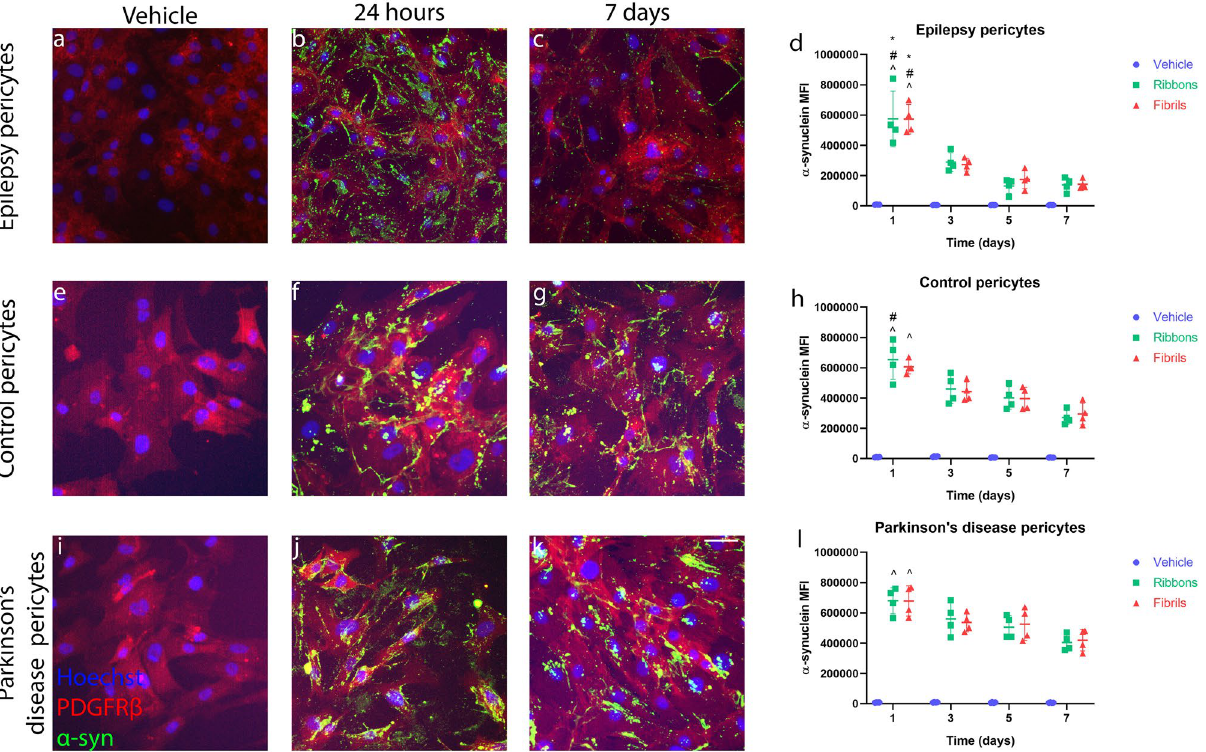
Figure 5. Degradation of α-syn in primary human brain pericytes. Immunocytochemistry images of pericytes incubated with α-syn fibrils (50 nM) for ( a ) vehicle, ( b ) 24 h, ( c ) 7 days in epilepsy pericytes. ( d ) α-syn MFI was measured using fixed flow cytometry with ribbons (50 nM) or fibrils (50 nM) over 7 days in epilepsy pericytes. Post-mortem control pericytes were exposed to α-syn fibrils (50 nM) for ( e ) vehicle, ( f ) 24 h, ( g ) 7 days in epilepsy pericytes. ( h ) α-syn MFI was measured using fixed flow cytometry with ribbons (50 nM) or fibrils (50 nM) over 7 days in control pericytes. Post-mortem PD pericytes were exposed to α-syn fibrils (50 nM) for ( i ) vehicle, ( j ) 24 h, ( k ) 7 days Scale bar = 10 µm. ( l ) α-syn MFI was measured using fixed flow cytometry with ribbons (50 nM) or fibrils (50 nM) over 7 days in control pericytes. Scale bar = 10 µm. ( n = 4 in each group, mean ± SD). * p < 0.05 compared to 3 day treatment, # p < 0.05 compared to 5 day treatment, ^ p < 0.05 compared to 7 day treatment; two way ANOVA with Tukey’s multiple comparisons